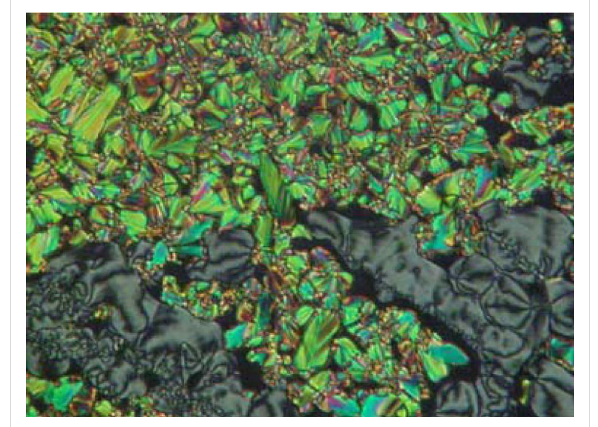
Figure 13: Compound OH 4b, exhibiting a fan-shaped texture together with a Schlieren texture upon cooling of the isotropic liquid, T = 145